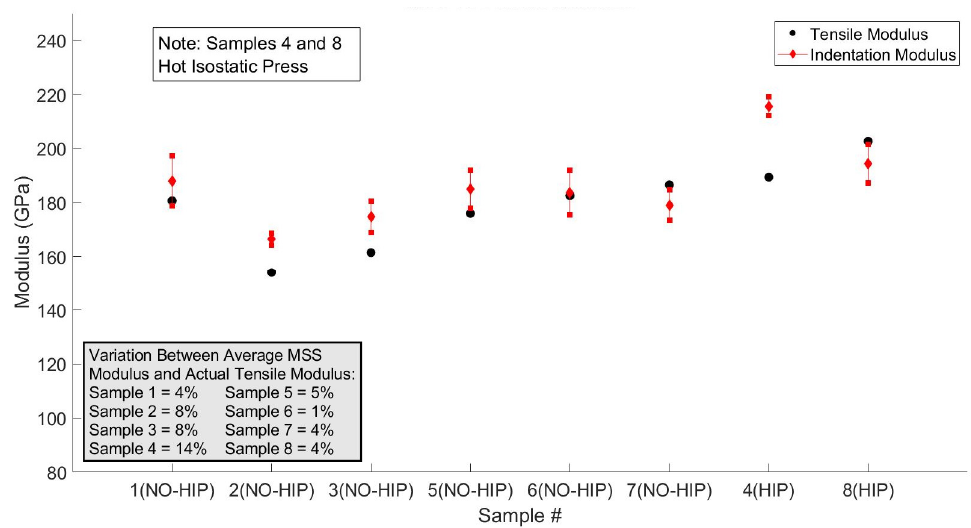
Figure 6. Estimated values of Young’s modulus obtained from MSS tests presented as averages and standard deviations, along with the corresponding UTT measurements. The table summarizes the percent variation between the average of the MSS moduli and the UTT modulus for each sample.